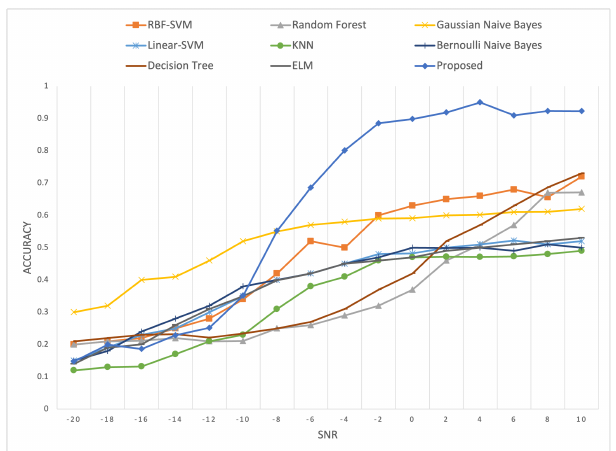
Figure 8. Classification accuracy of the various traditional feature-based methods on D 2.